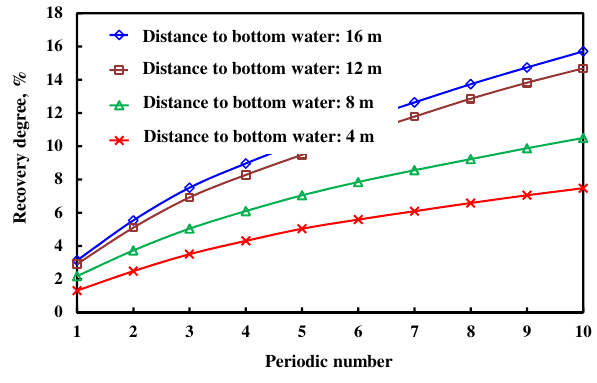
Fig. 4 Effect of distance from horizontal well to bottom water on final recovery degree